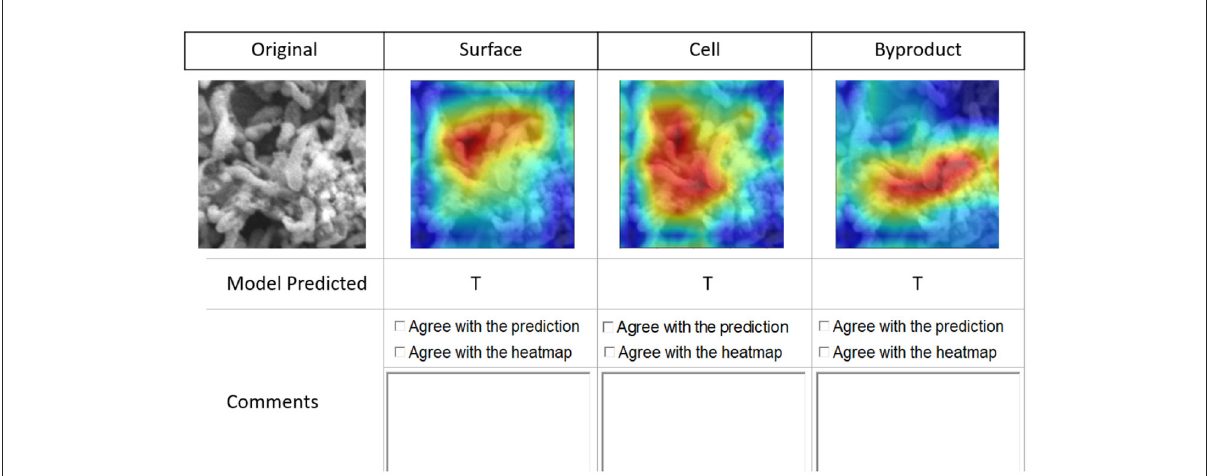
FIGURE6 Interface for qualitative feedback. Image in the first row, first column shows an image patch followed by three columns of CAMs showing the true for class Surface , true for class Cells , and true for class Byproduct . Checkboxes and textboxes in the bottom half of the figure are available to input experts’ agreements and